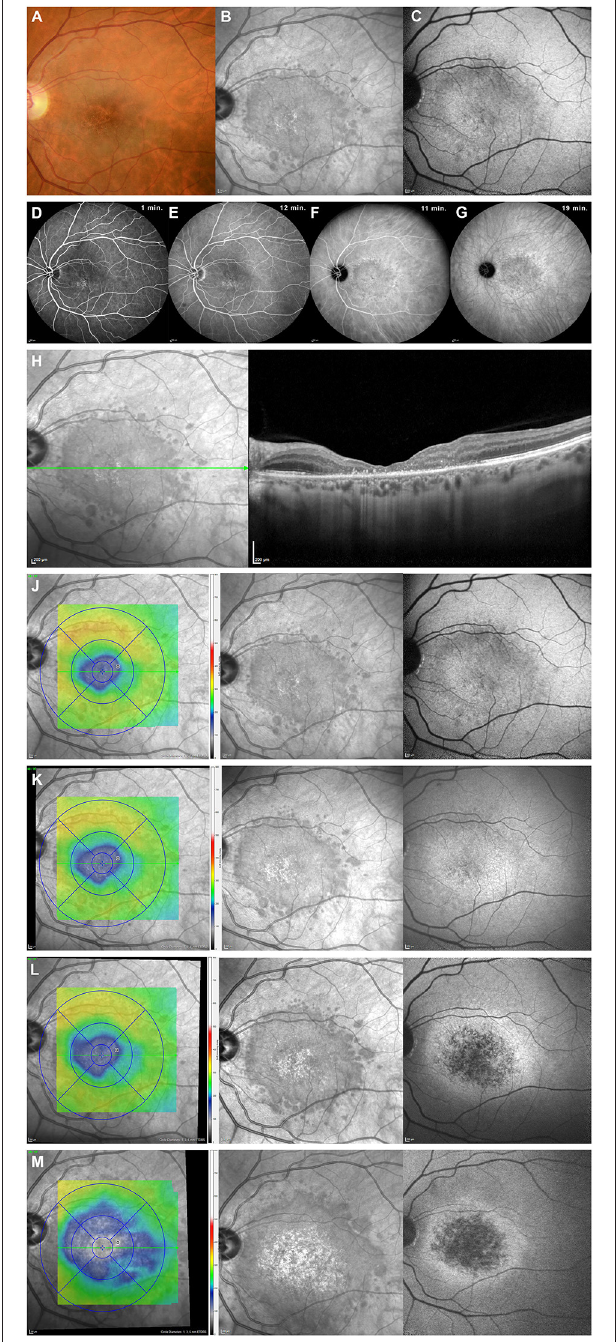
FIGURE 1 | Multimodal imaging of ritonavir toxic maculopathy (patient 1). Top row—Initial examination of fundus showed discrete macular atrophy of granular appearance (A) . A wider extent of maculopathy was best demonstrated by pseudo-infrared photography (B) , which very precisely delineated borders of maculopathy. Autofluorescence fundus photography (C) was somehow less informative than pseudo-infrared technique. Second row—Retinal fluorescein angiography showed a mottled hyperfluorescent appearance of left macula, from early phase on (D) , without leakage in intermediate or late phases (E) , resulting from retinal pigment epithelium (RPE) (Continued)